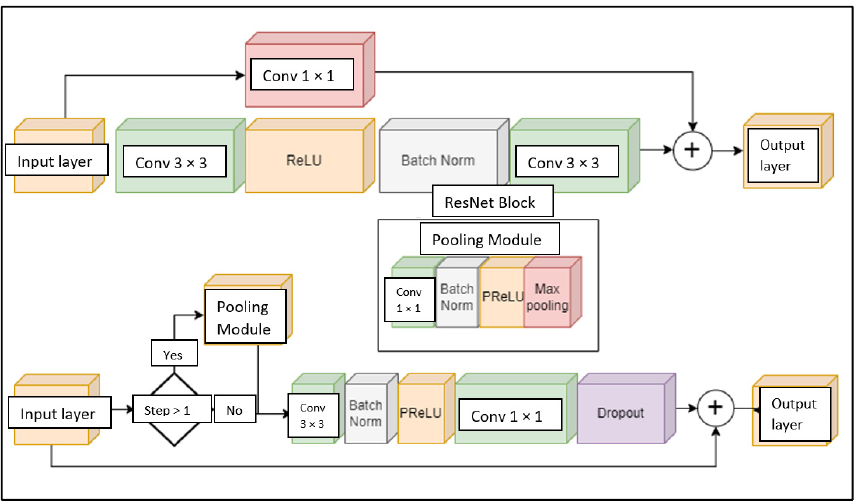
Figure 5. E-module based on ResNet block design.